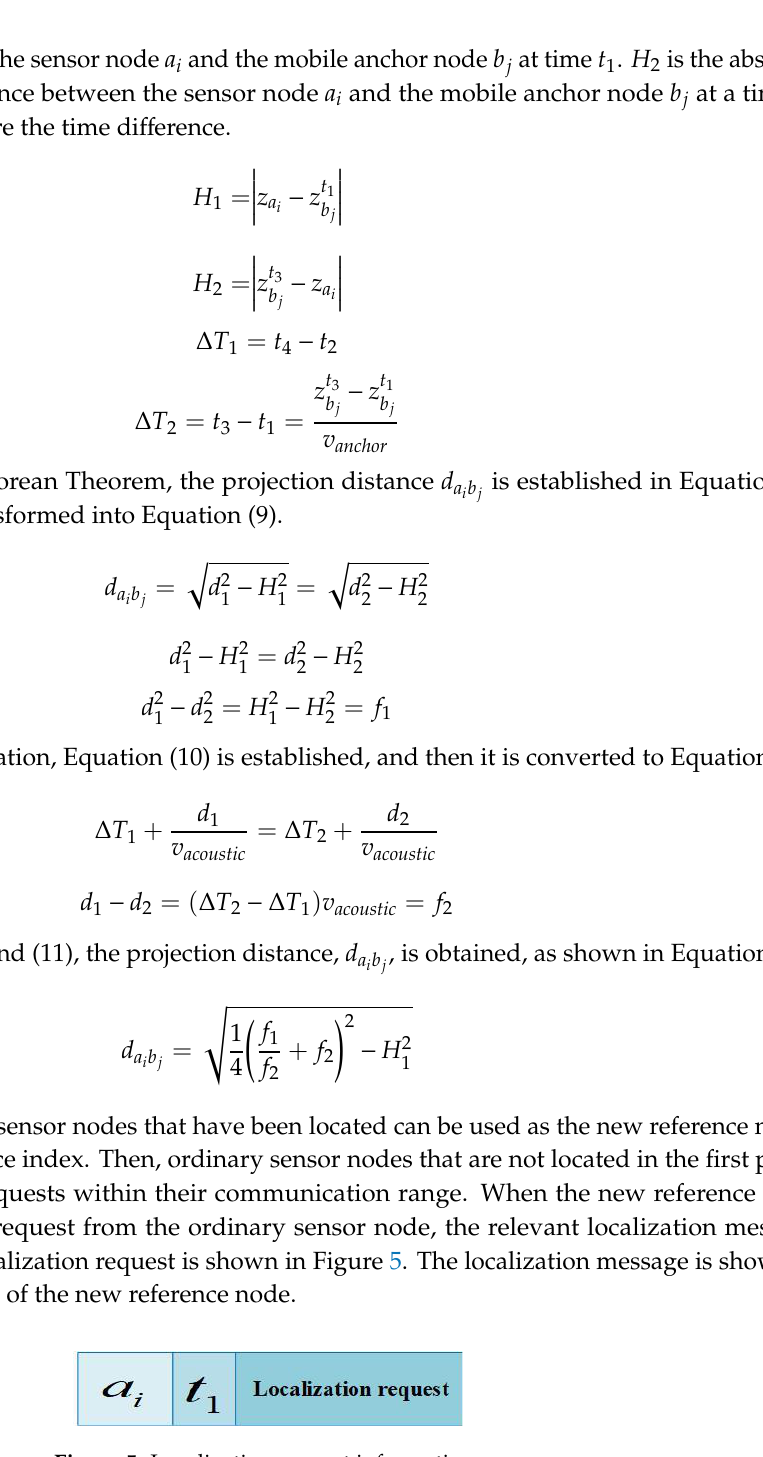
Figure 5. Localization request information.